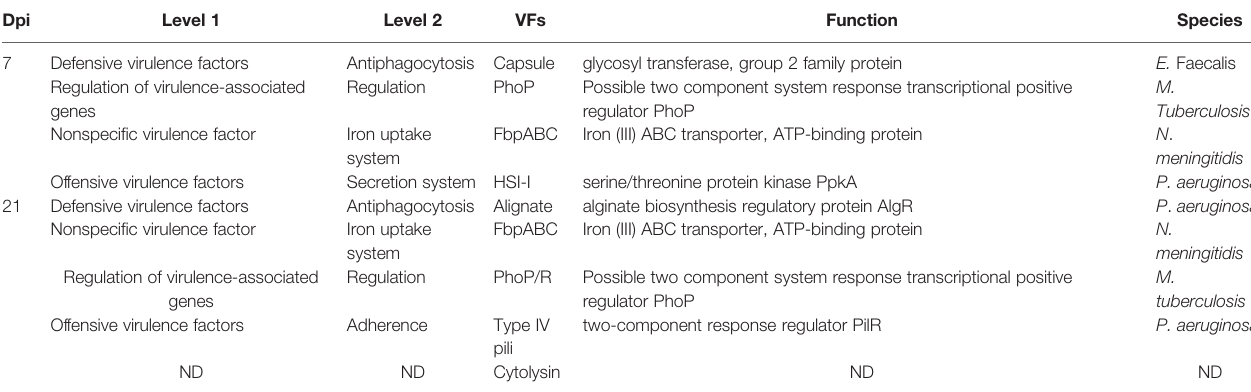
TABLE 4 | Top differentially abundant virulence factors between high and low H/L ratio SE-infected chickens based on VFDB database annotation.